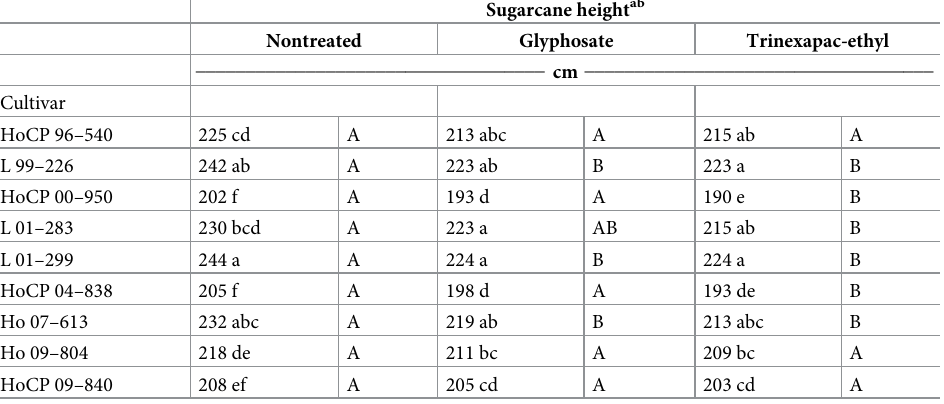
a Sugarcane stalks were measured from the base of the plant to the last fully expanded internode. b Means within a ripener that are followed by the same lower case letter and means within a cultivar that are followed by the same upper case letter are not significantly different according to Tukey HSD